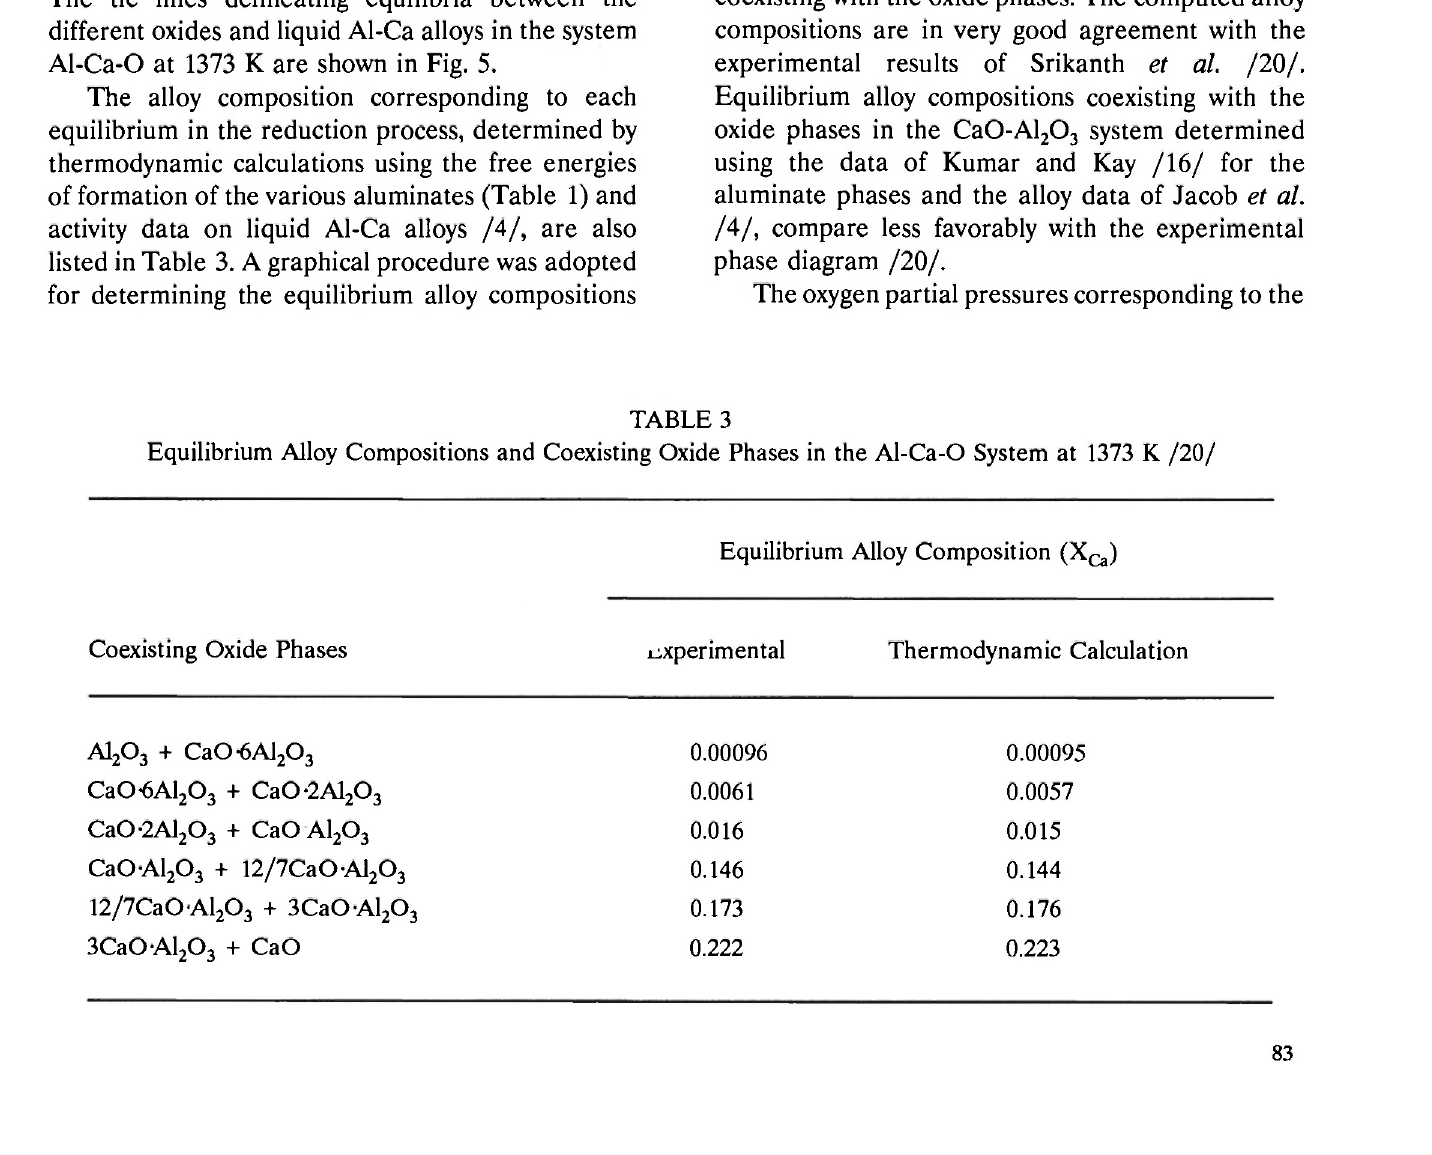
Equilibrium Alloy Compositions and Coexisting Oxide Phases in the Al-Ca-O System at 1373 Κ /20/